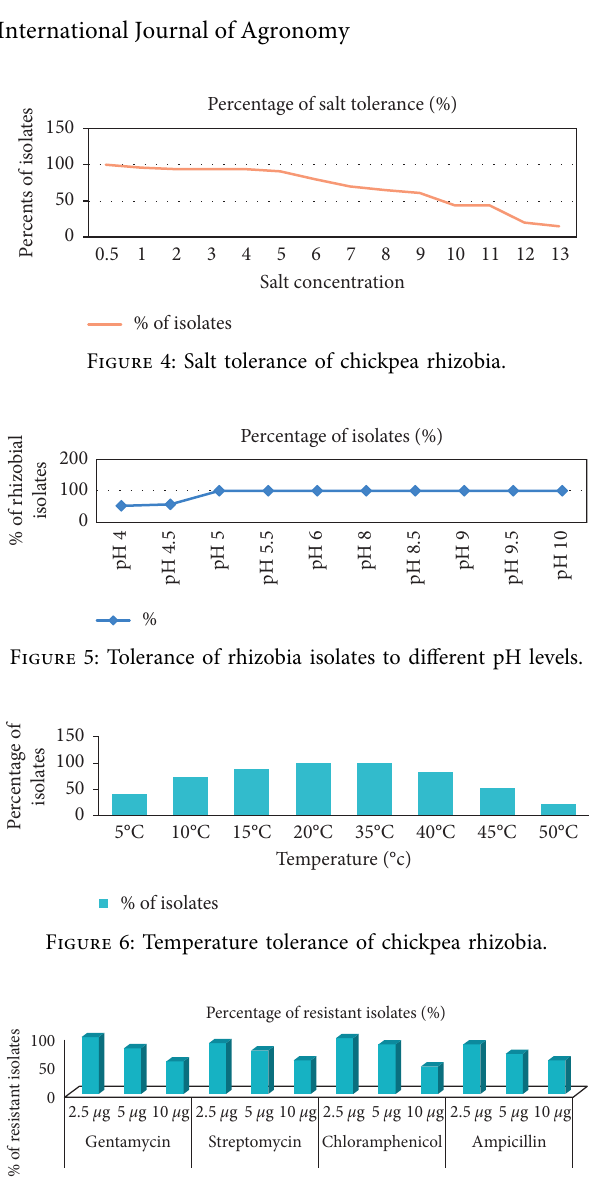
Figure 7: Antibiotics tolerance of chickpea rhizobial isolates.